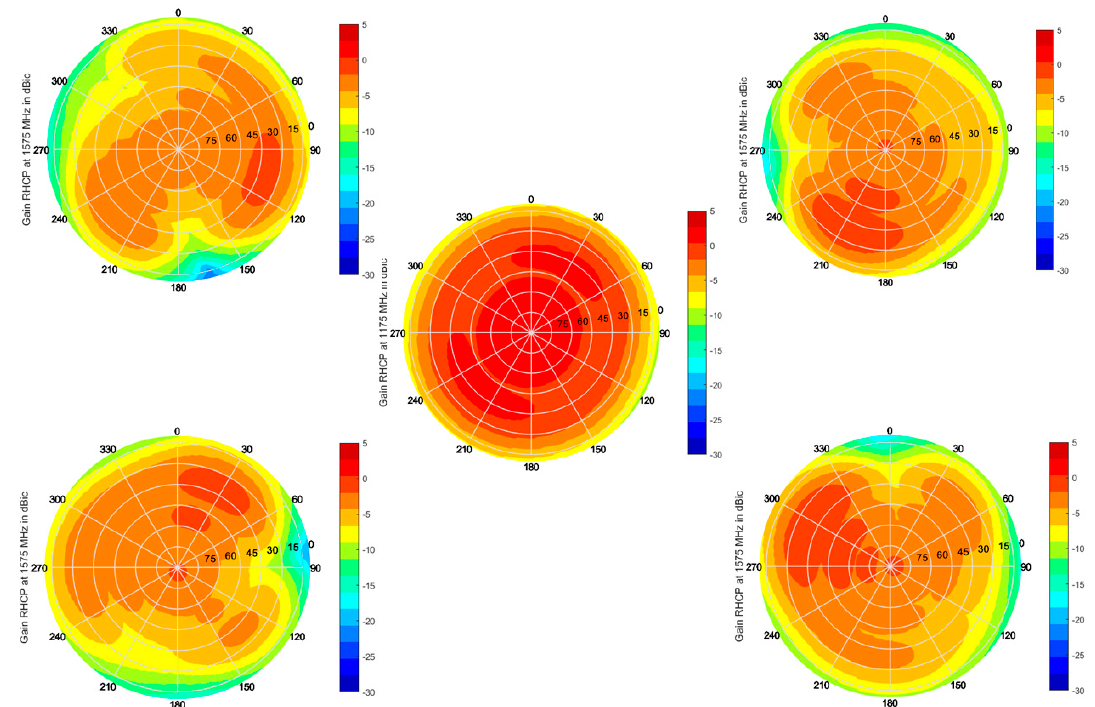
Figure 10. Sky plots of the embedded antenna RHCP gain in dBic, as measured in the anechoic chamber.